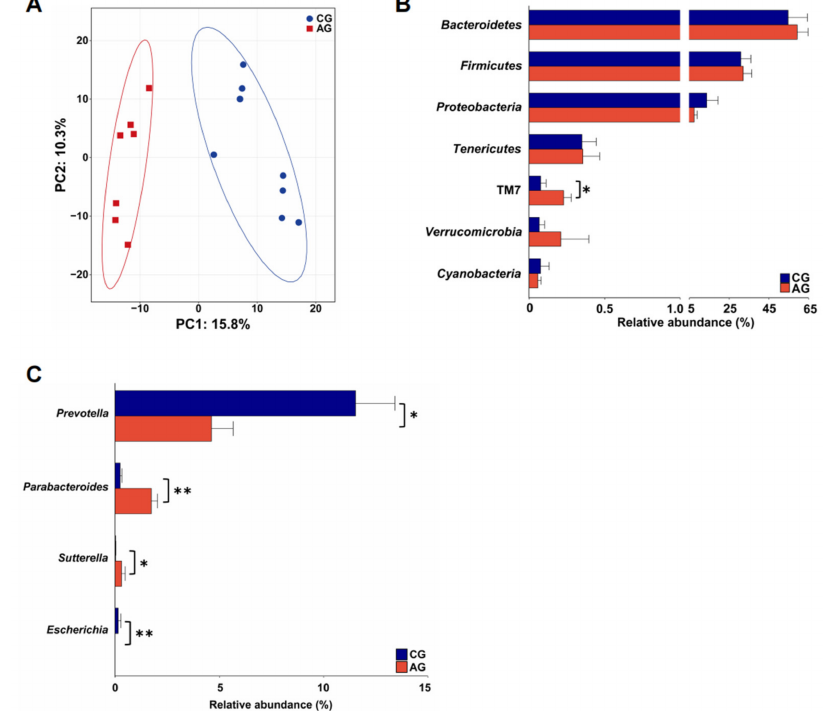
Figure 8. Profiles of gut microbiota composition in mice. ( A ) Gut microbiota compositional profiles of CG and AG mice based on genera visualized by PCA. ( B ) Gut microbiota composition at the phylum level of CG and AG mice. All the microbial phyla are displayed. ( C ) Differential gut microbiota genera between the CG and AG mice. Data are expressed as mean ± SEM. * p < 0.05 and ** p <